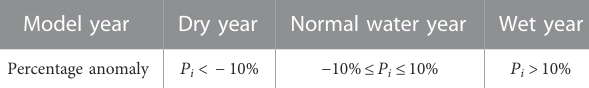
TABLE 1 Classi fi cation basis of the year